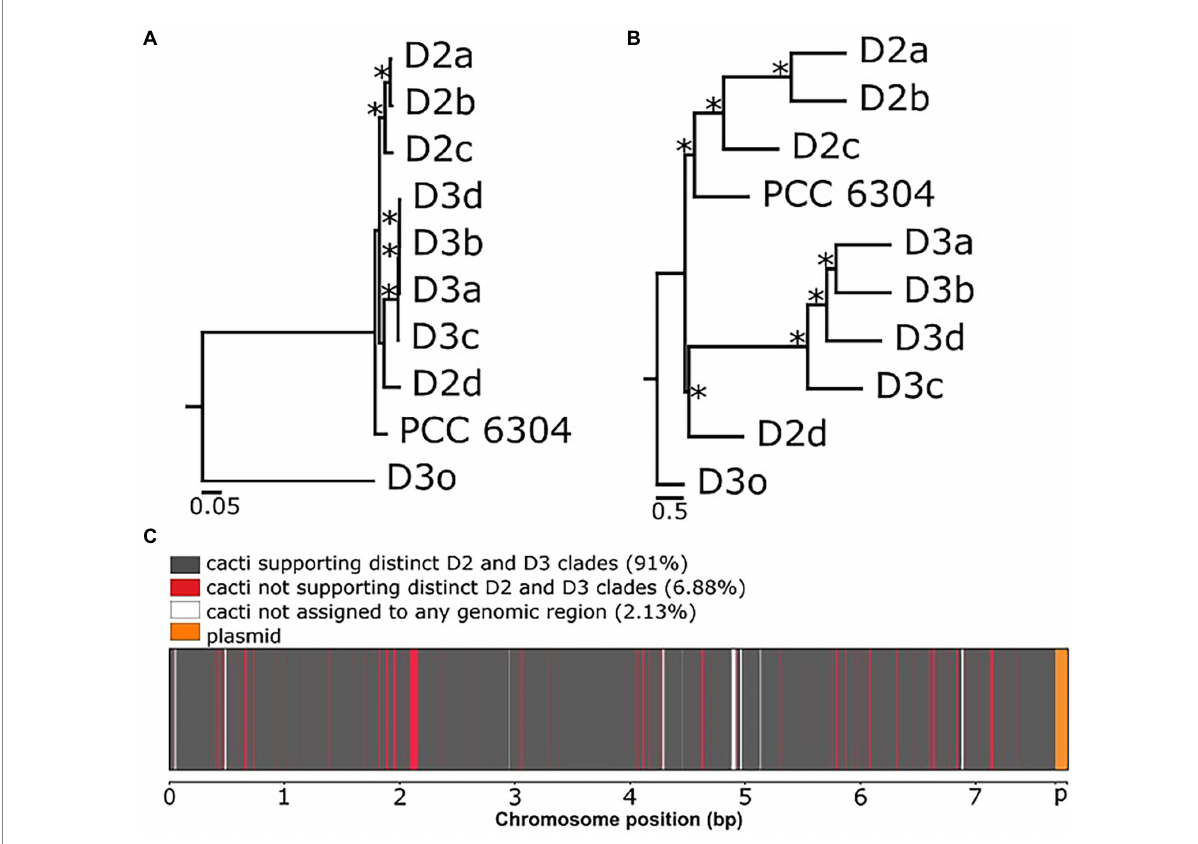
FIGURE 1 Phylogenetic relationships and genealogical discordance in the chromosome of Laspinema . (A) Maximum likelihood (ML) species tree based on 2,595 single-copy orthologues. Asterisks represent ultrafast bootstrap support ≥ 99. The scale bar indicates substitutions per site. (B) ASTRAL species tree based on individual gene trees of the 2,595 single-copy orthologues. Asterisks represent coalescent units of 1. The scale bar indicates substitutions per site. (C) Saguaro plot illustrating the distribution of local phylogenetic topologies over the chromosome of Laspinema . Genomic regions supporting the differentiation of isolates into two clades (D2 and D3) are shown in dark grey, and genomic regions not supporting it are shown in red. The letter ‘p’ marks the location of the plasmid, and it is shown in orange. Genomic regions in white were not assigned to any of the detected cacti. See Supplementary Figure S4 for further details on local topologies inferred by Saguaro with the percentage of the genome cacti